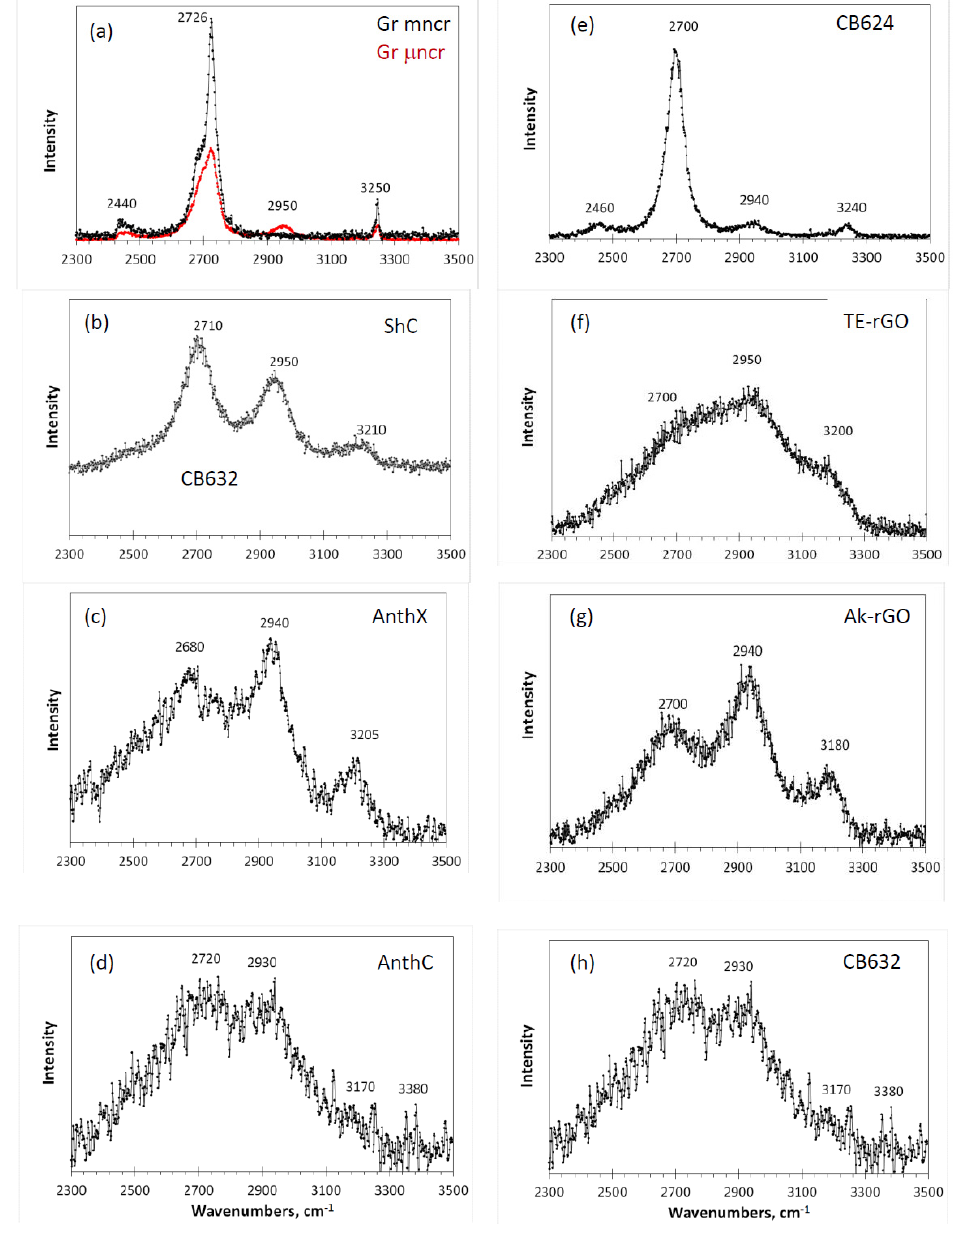
Figure 8. Two-phonon Raman spectra of sp 2 amorphous carbons. Sample and ( a – h ) markings are the same as in Figure 4.